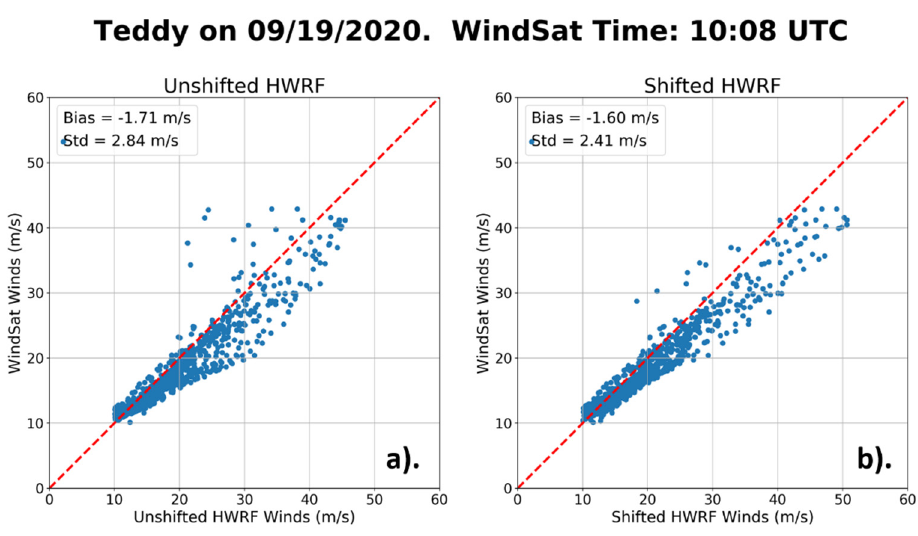
Figure 11. Scatterplots of WindSat matchups with interpolated resampled HWRF fields for Hurricane Teddy on 19 September 2020 at 10:08 UTC. ( a ) shows matchups with the HWRF wind field that has been temporally interpolated to the time of the WindSat overpass. ( b ) shows matchups with the HWRF wind field created by first shifting then interpolating the surrounding winds. The dashed red line represents the one-to-one line (i.e., no bias).